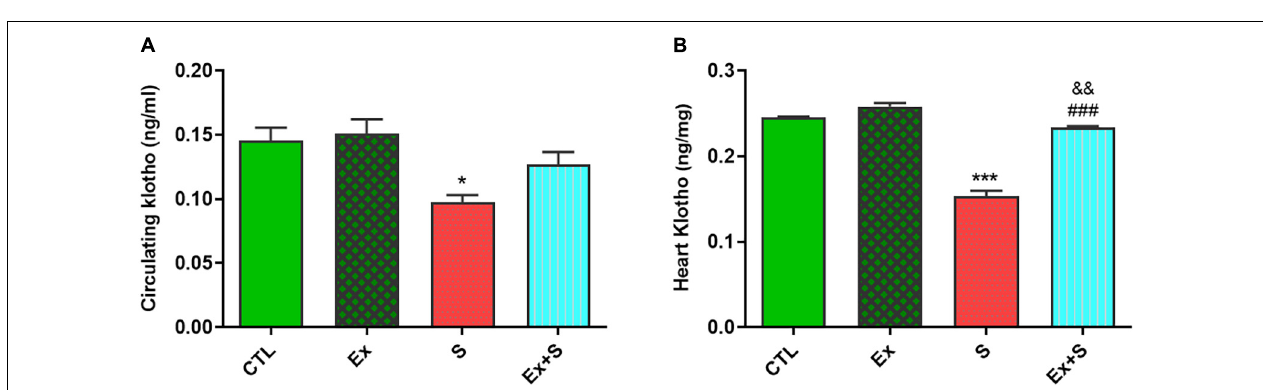
FIGURE 6 | Effects of waterpipe smoke inhalation on α -Klotho levels in serum (A) and in the heart (B) in experimental groups. CTL, control group; Ex, group subjected to exercise training for 8 weeks; S, group subjected to waterpipe tobacco smoke inhalation for 8 weeks; Ex + S, group subjected to exercise training and waterpipe tobacco smoke inhalation for 8 weeks. The results are presented as mean ± SEM, n = (6–7). * P < 0.05; *** P < 0.001 vs. CTL; ### P < 0.001 vs. S; && P < 0.01 vs.